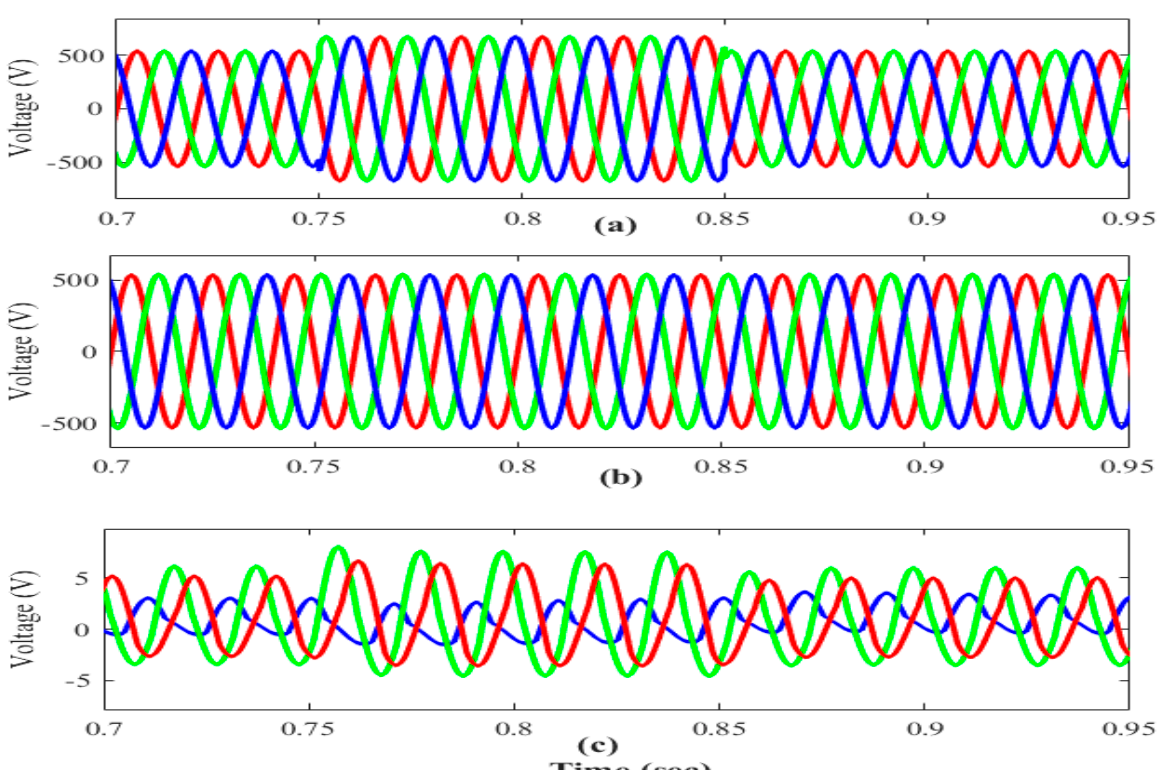
Figure 17. Analysis of voltage swell conditions ( a ) Source Voltage ( b ) Load Voltage ( c ) Injected Voltage.